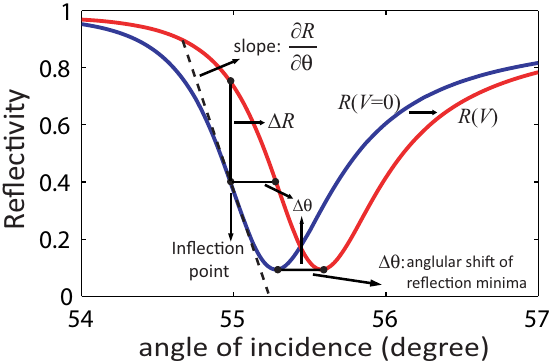
Figure 3. Representative reflective curves without bias R ( V = 0) and with bias R ( V ) to the film as a function of angle of incidence. Δ R can be measured using a lock-in amplifier and the slope ∂ R / ∂θ can be obtained by numerical differentiation of the experimental reflectivity